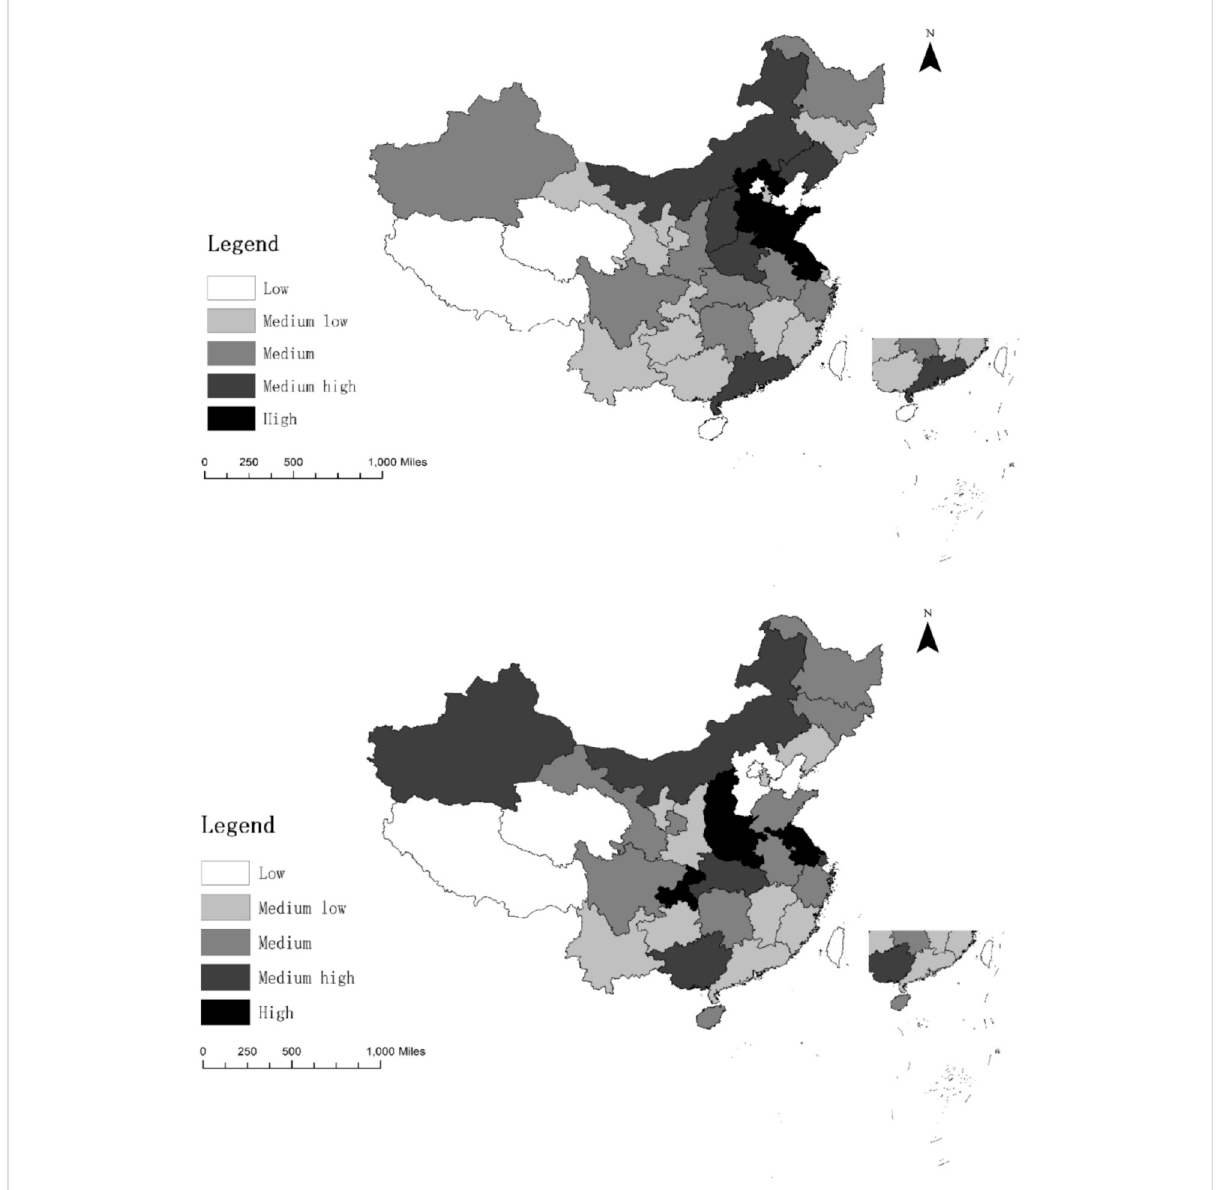
FIGURE 1 Regional distribution of carbon emissions in China in 2014 (top) and 2019